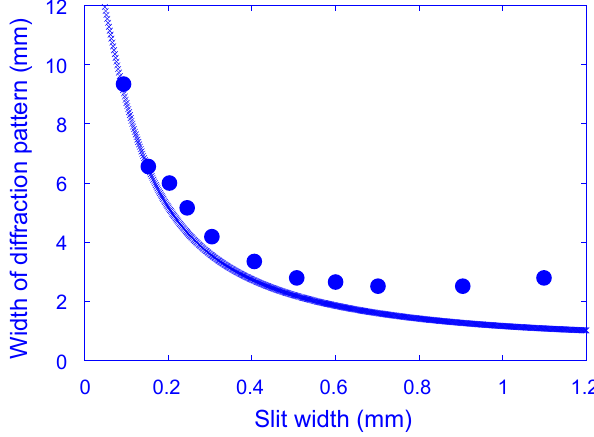
Figure 7: Width of the di ff raction pattern, plotted against the full width of slit A. The circles represent the data of Strekalov et al’s experiment [32]. The line represents the theoretical width, calculated from Equation 20 for (cid:126) /σ = 0 . 04 mm, using the parameters of Strekalov et al’s